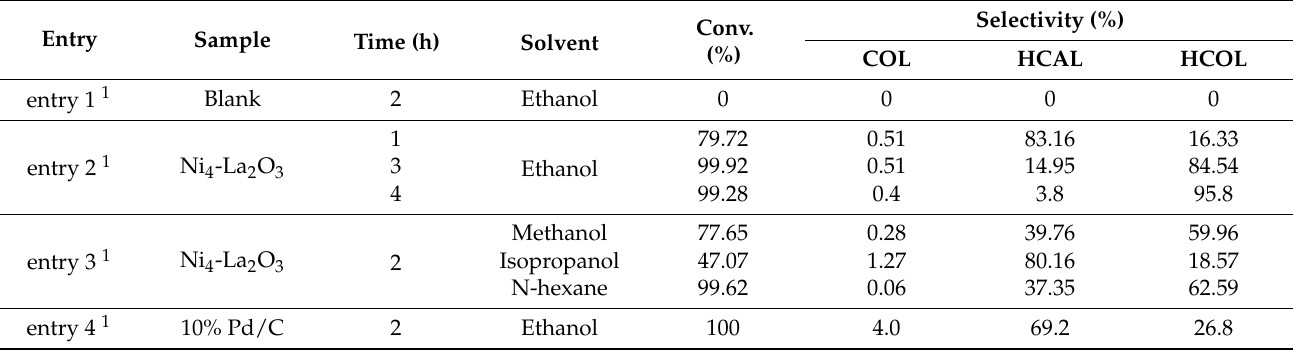
Table 1. Catalytic hydrogenation of CAL over different reaction conditions.